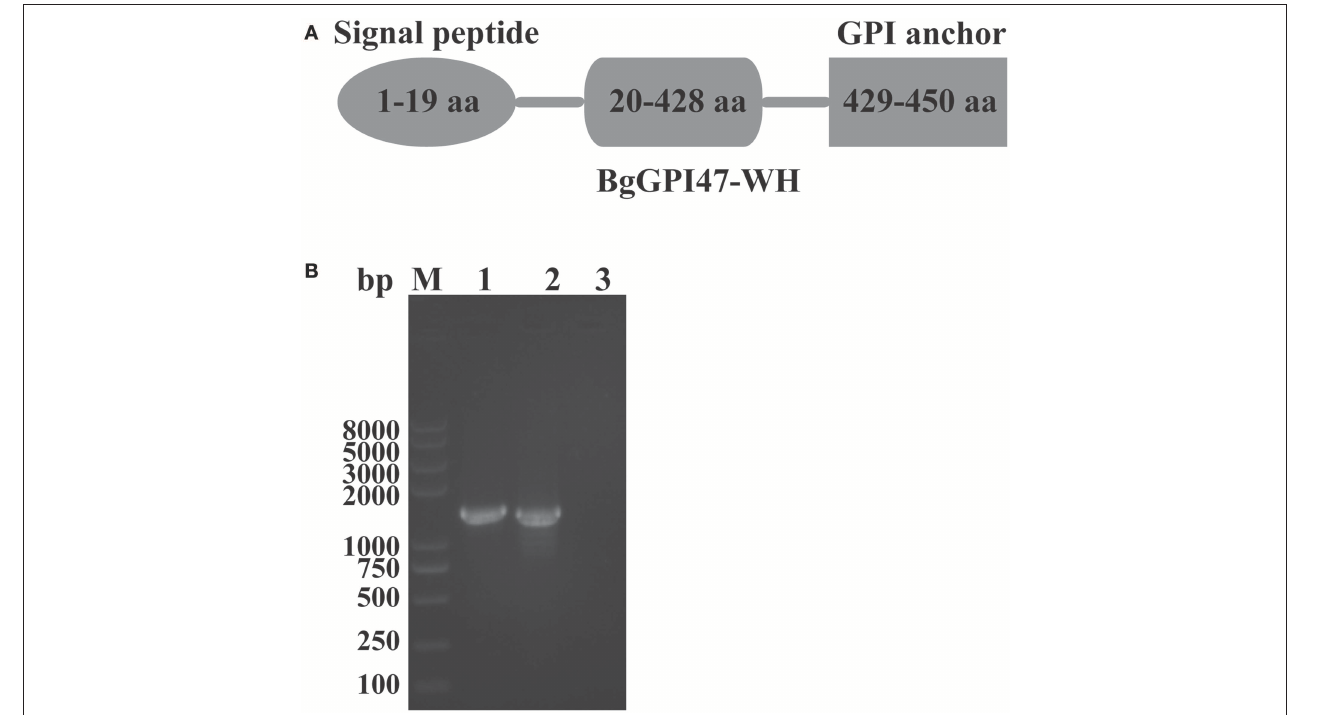
FIGURE 1 | Sequence analysis of BgGPI47-WH. (A) Graphic depiction of BgGPI47-WH ORF. The sequence of BgGPI47-WH includes a signal peptide at the N-terminus and a typical GPI anchor at the C-terminus. (B) The PCR amplification of BgGPI47-WH genes from gDNA and cDNA of B. gibsoni . Lane M: Marker; lane 1: The BgGPI47-WH from gDNA; lane 2: The BgGPI47-WH from cDNA; lane 3: Negative control.